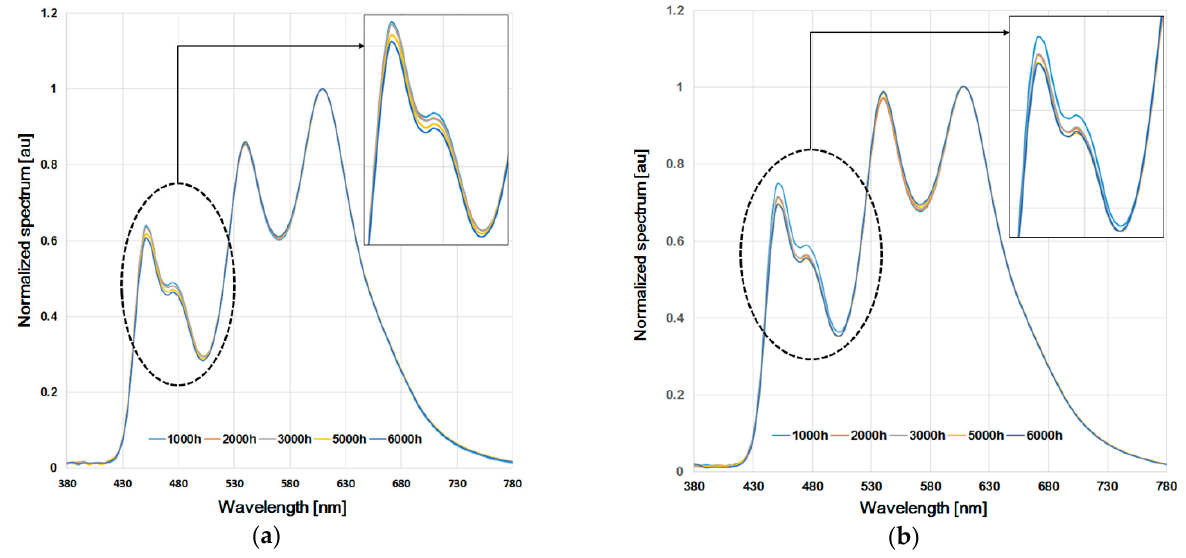
Figure 4. Normalized spectrum variation with operating time. ( a ) OLED panel type A ( b ) OLED luminaire type E.